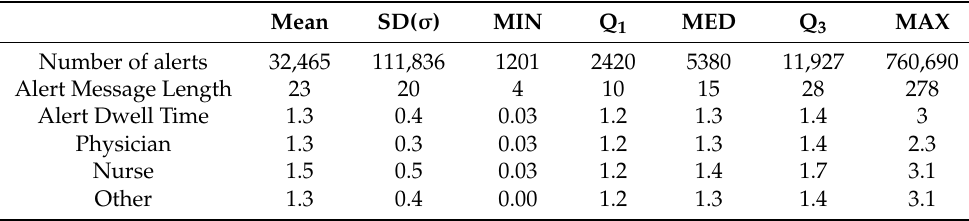
Table 1. The descriptive statistics for each alert characteristic (N =